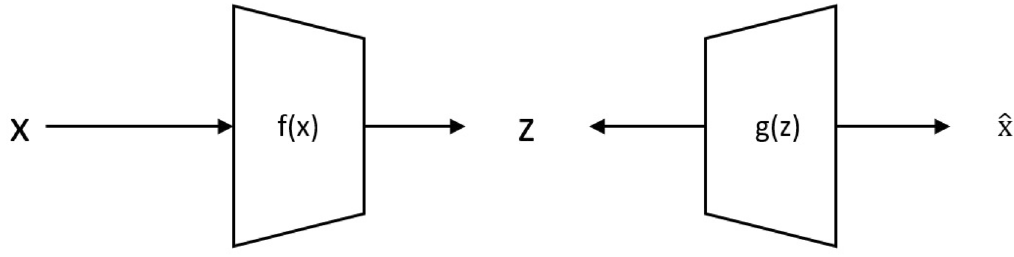
Figure 3. Basic structure of